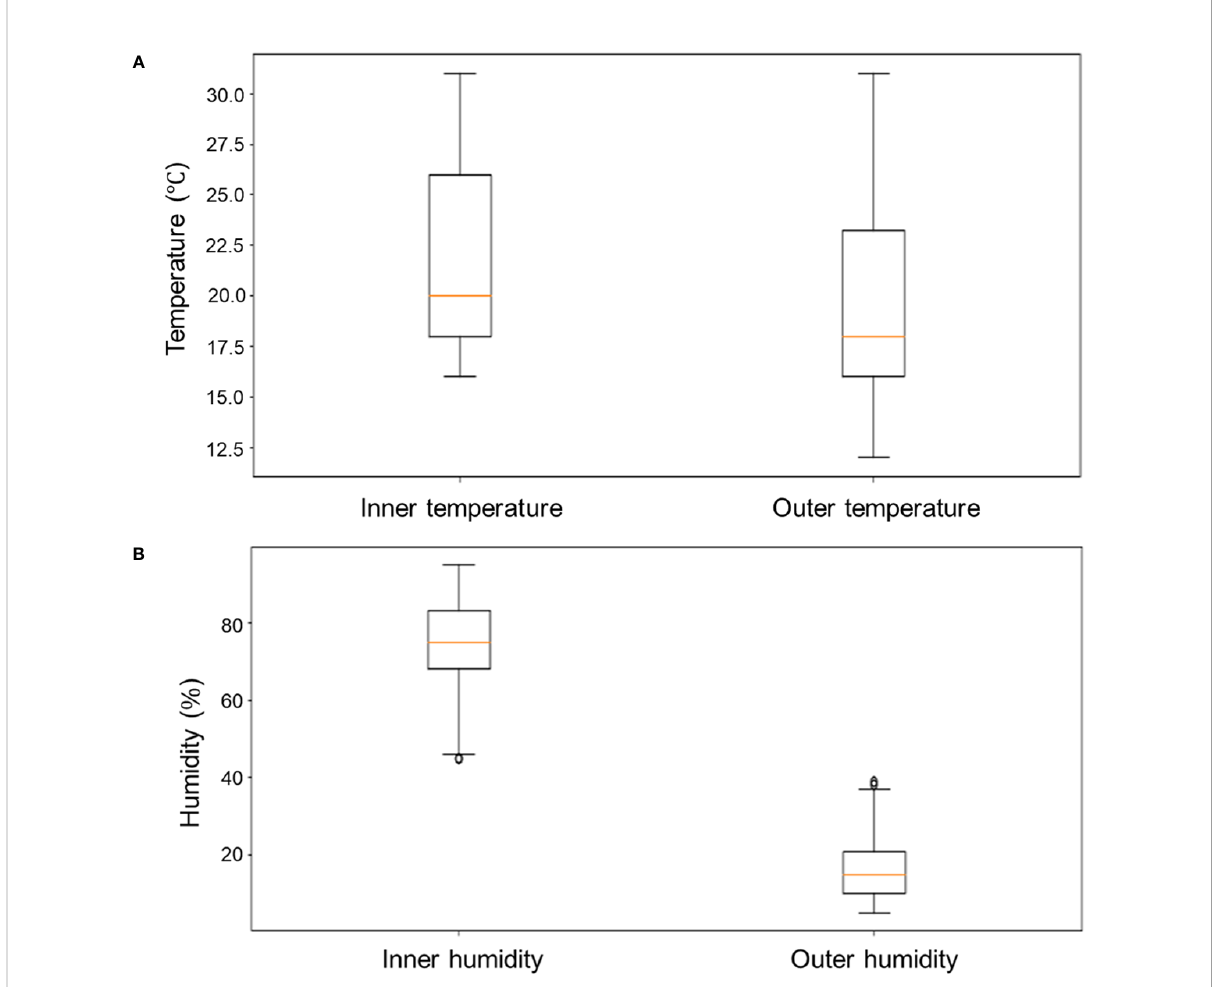
FIGURE 10 Comparison of boxplots according to the internal and external conditions of the cultivator. (A) Temperature and (B) humidity.